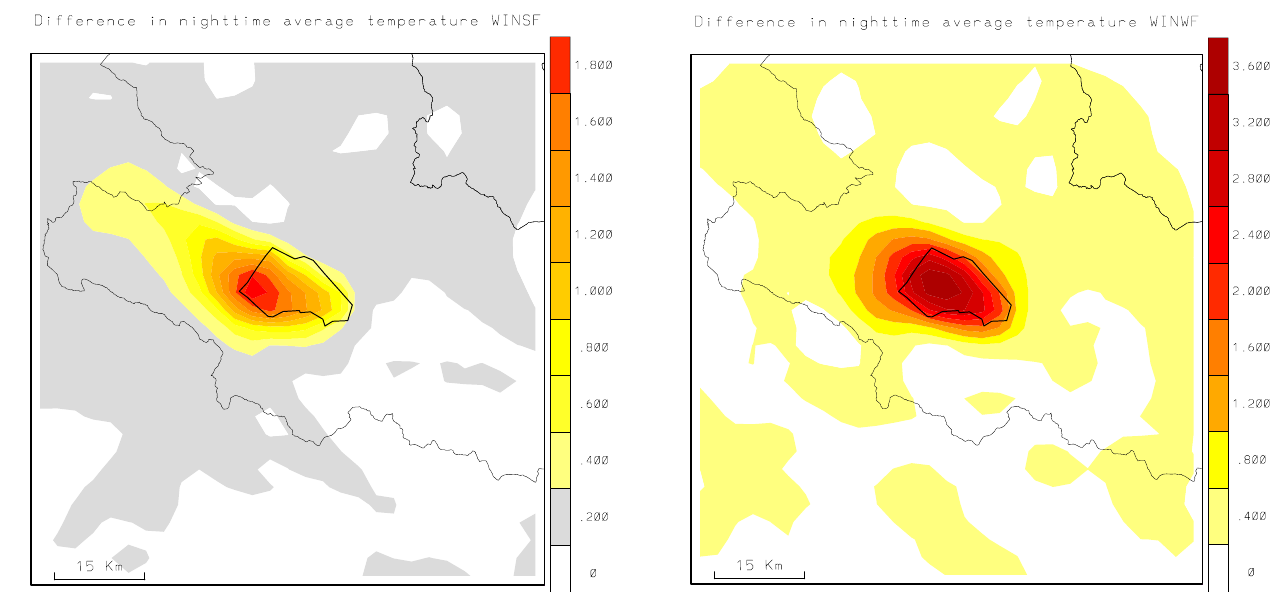
culate actual evaporation from potential